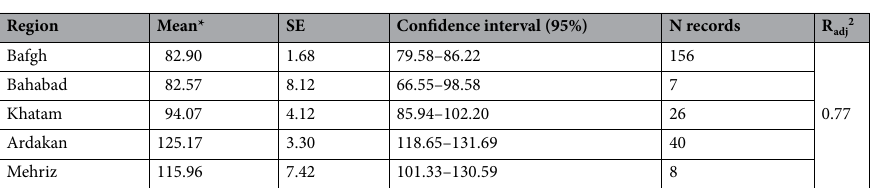
Region Mean* SE Confidence interval (95%) N records R adj2